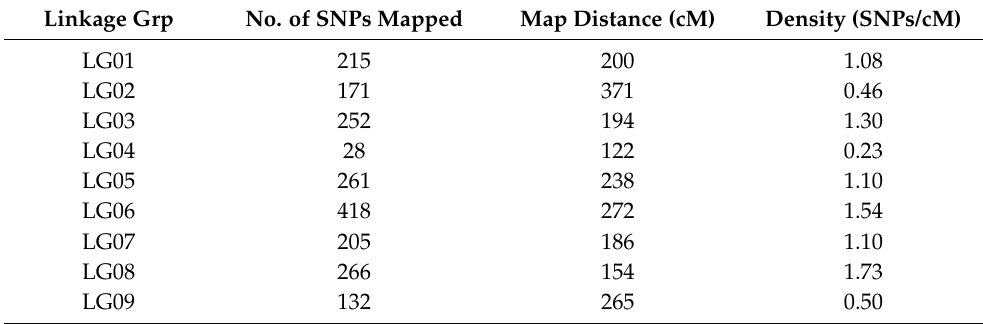
Table 4. Distribution of markers on the 12 linkage groups (LGs) of rice genetic map for the MTU1010 X Ranbir Basmati RIL population.